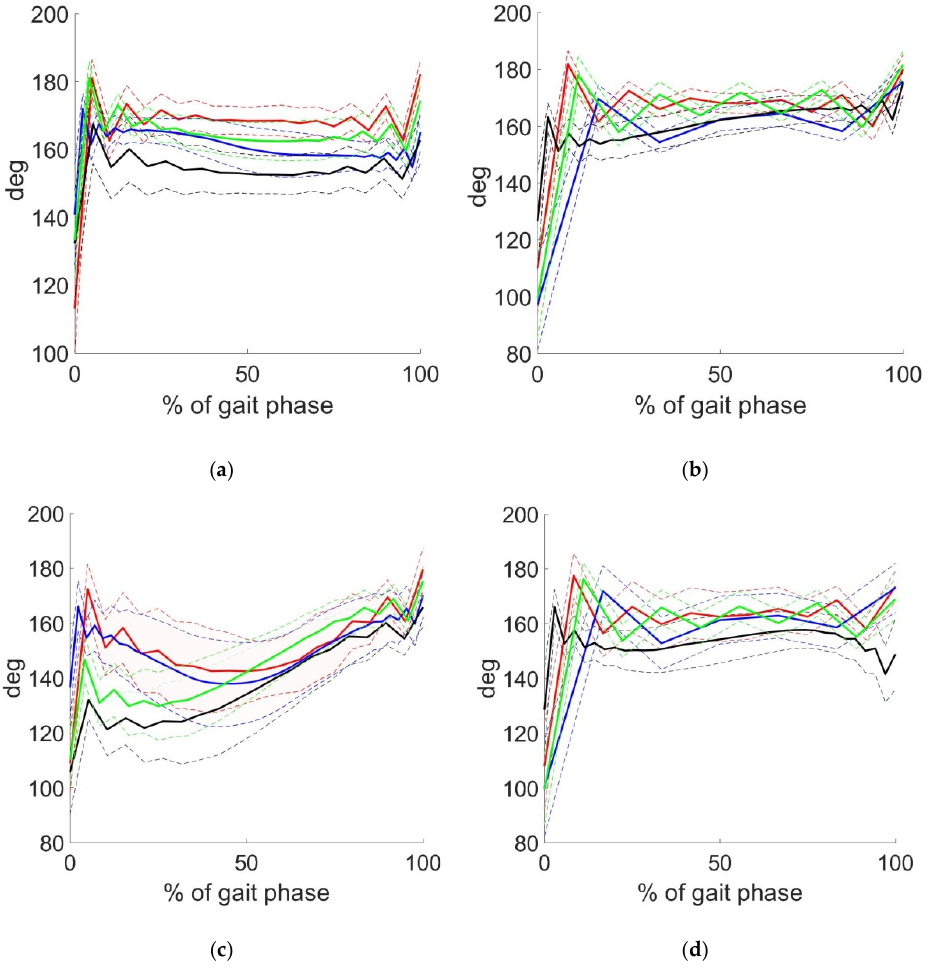
Figure 7. Changes in the hip and knee angles (°) in phases for clusters: ( a ) hip angle in the swing phase, ( b ) hip angle in the stance phase, ( c ) knee angle in the swing phase, ( d ) knee angle in the stance phase. Color designations: red—1 group, blue—2 group, black—3 group, green—4 group.